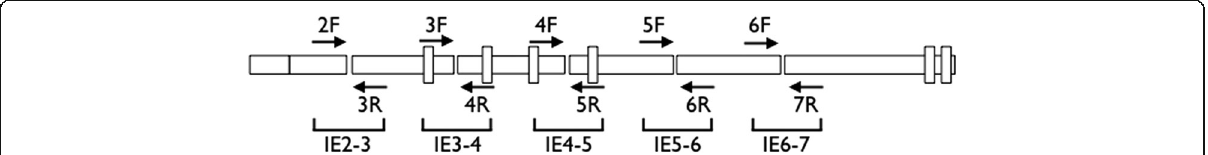
Fig. 1 Diagram of the location of the primers and the amplified regions in each PCR. Each PCR was designed between the final part of the preceding exon and the initial part of the next one. This design allows to avoid genomic contamination and also gives us information about the presence of non-canonical